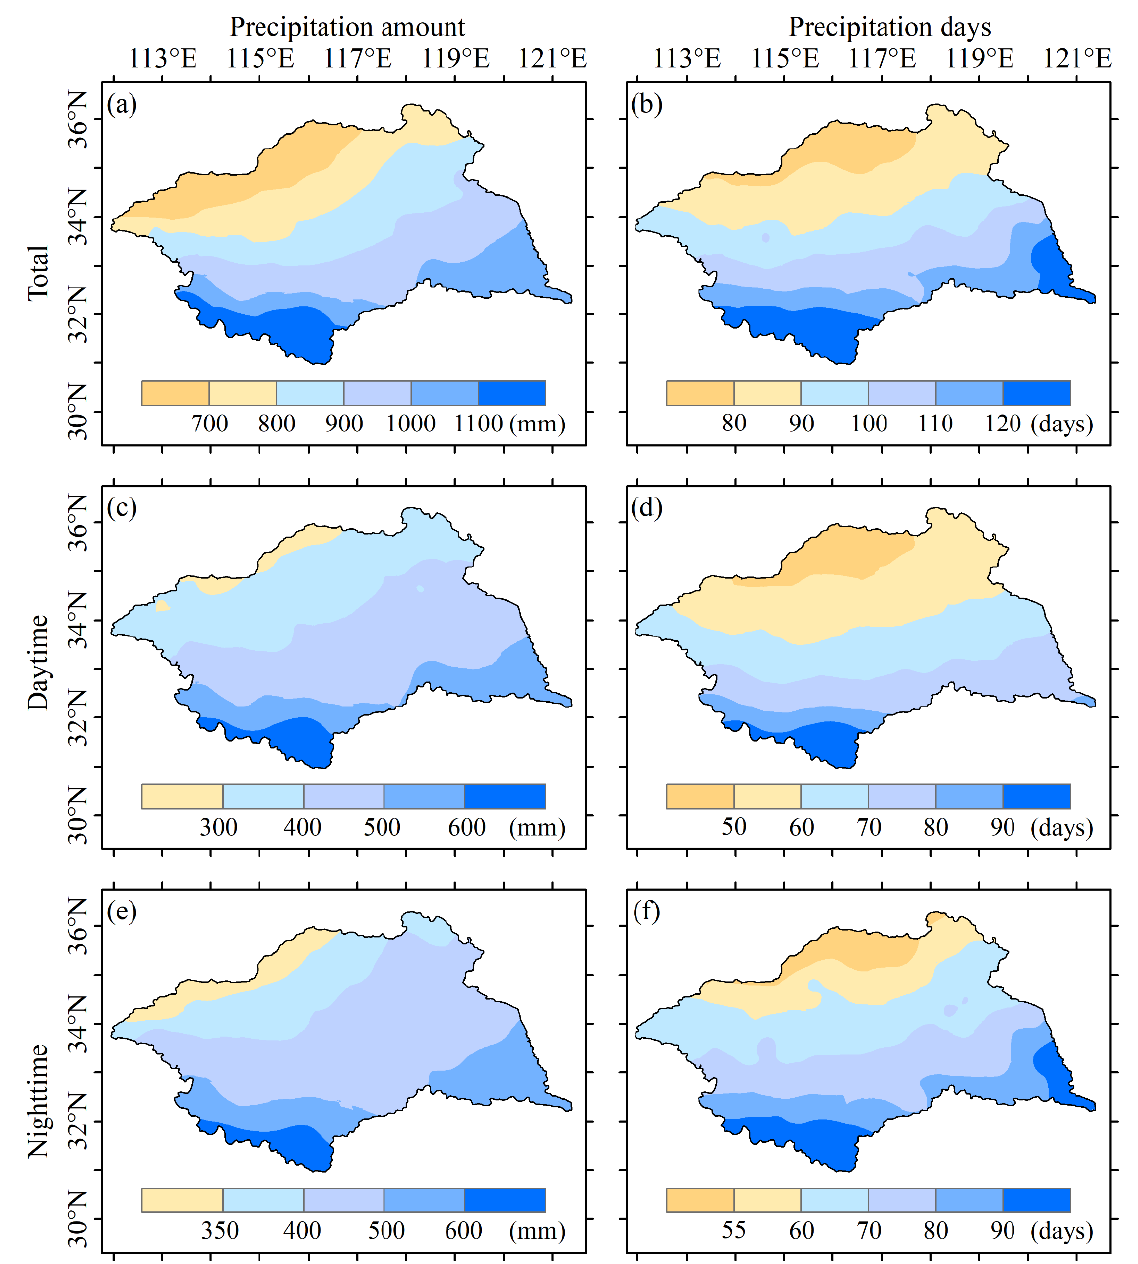
Figure 4. Spatial amount and days of ( a , b ) total daily, ( c , d ) daytime, and ( e , f ) nighttime precipitation in the HRB from 1961 to 2018.